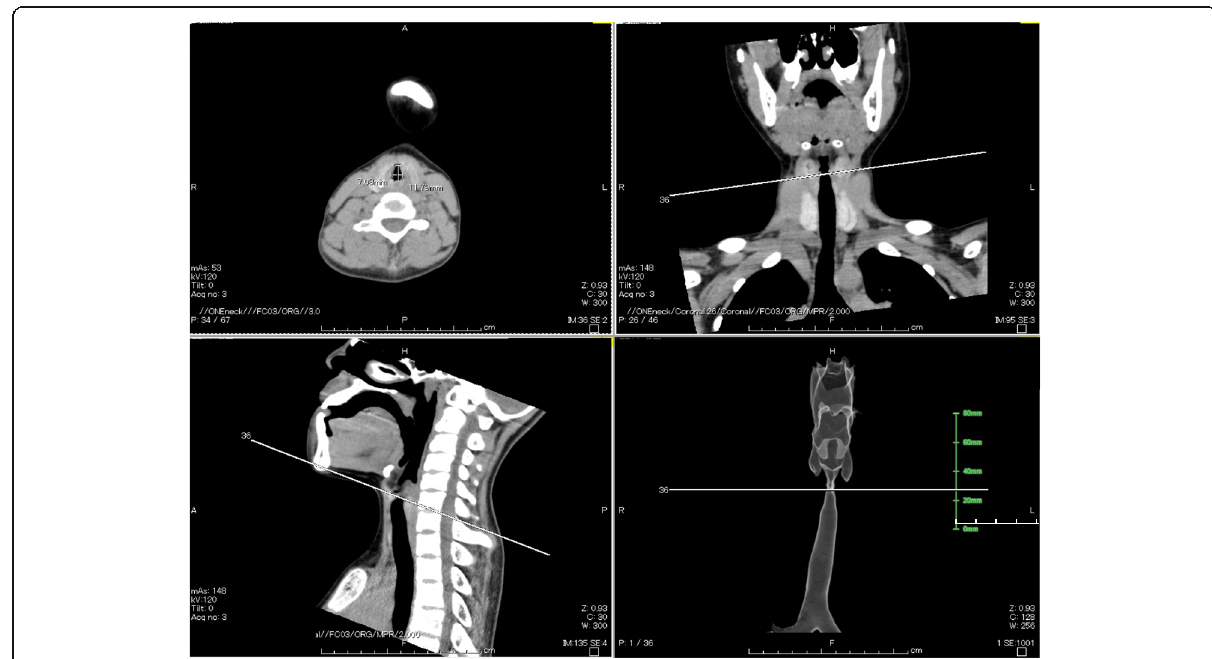
Fig. 2 Cervical computed tomography showed the narrowest site of the airway was in laryngeal region, not at the lower airway